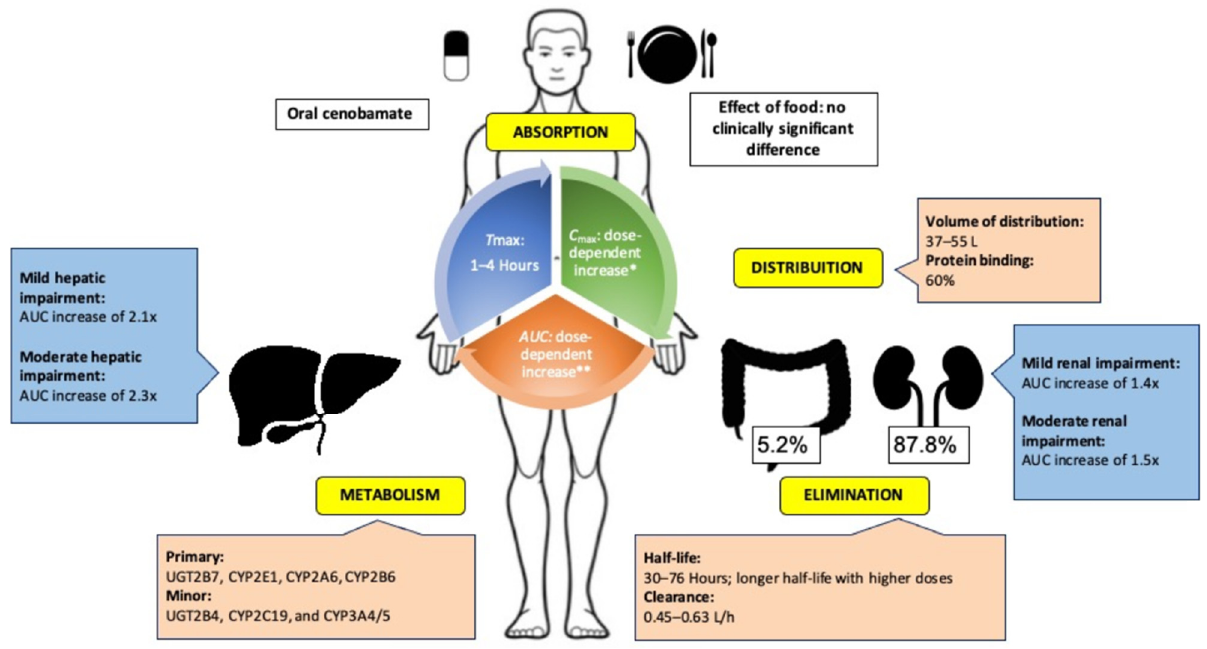
Figure 2. Pharmacokinetics of cenobamate.